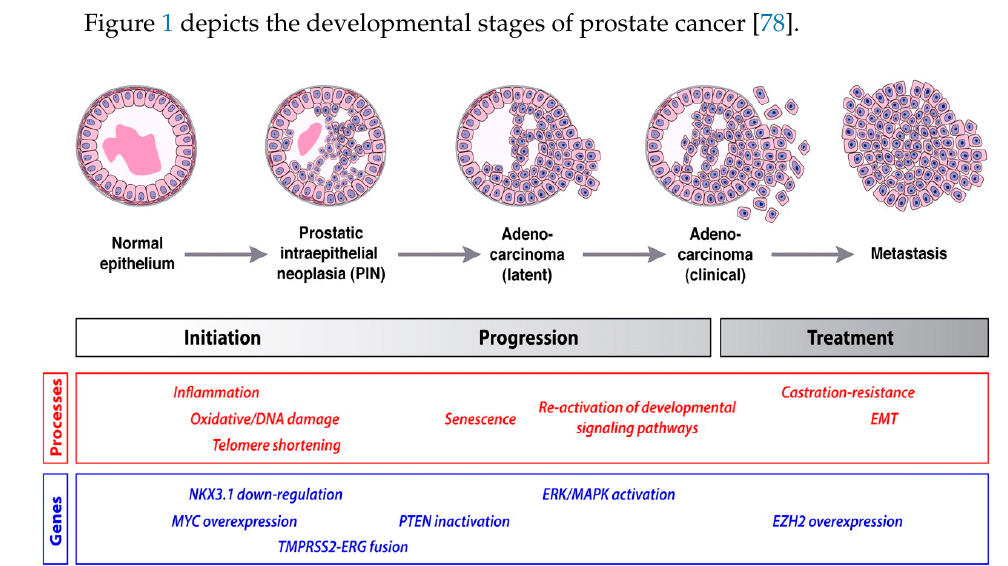
and proliferation, EZH2 is a novel target for prostate cancer